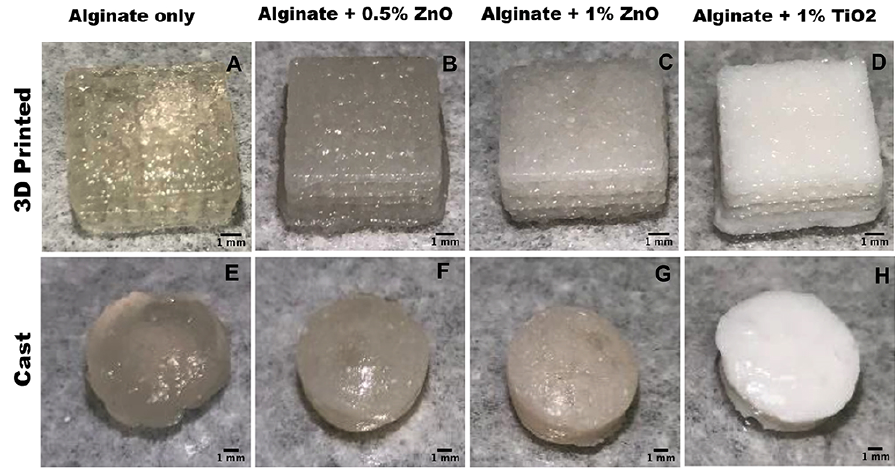
Figure 10. ( A – D ) depict 3D-printed lattice structures. ( E – H ) portray manually casted structures. Scale bar in all images depict 1 mm. Reprinted from [152].